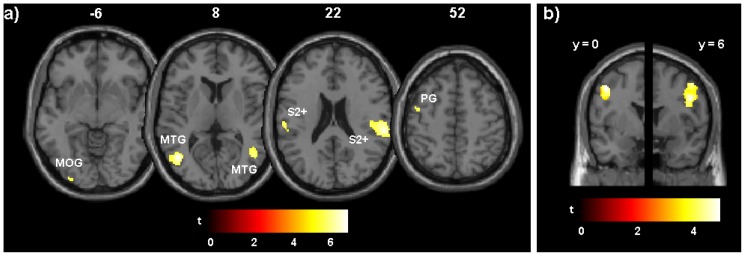
Results for the conjunction analysis.a) whole brain analysis (p<.05, FWE-corrected); the number above each slice indicates the height (z-coordinate in Montreal Neurological Institute [MNI] space); b) analysis for bilateral ventral premotor cortex using regions of interest (p<.005, uncorrected); given is the y-coordinate of the slices of peak activity (in MNI space). MOG =  middle occipital gyrus; MTG =  middle temporal gyrus; S2+ =  secondary somatosensory cortex plus its vicinity; PG =  precentral gyrus. Color bars indicate t-values.